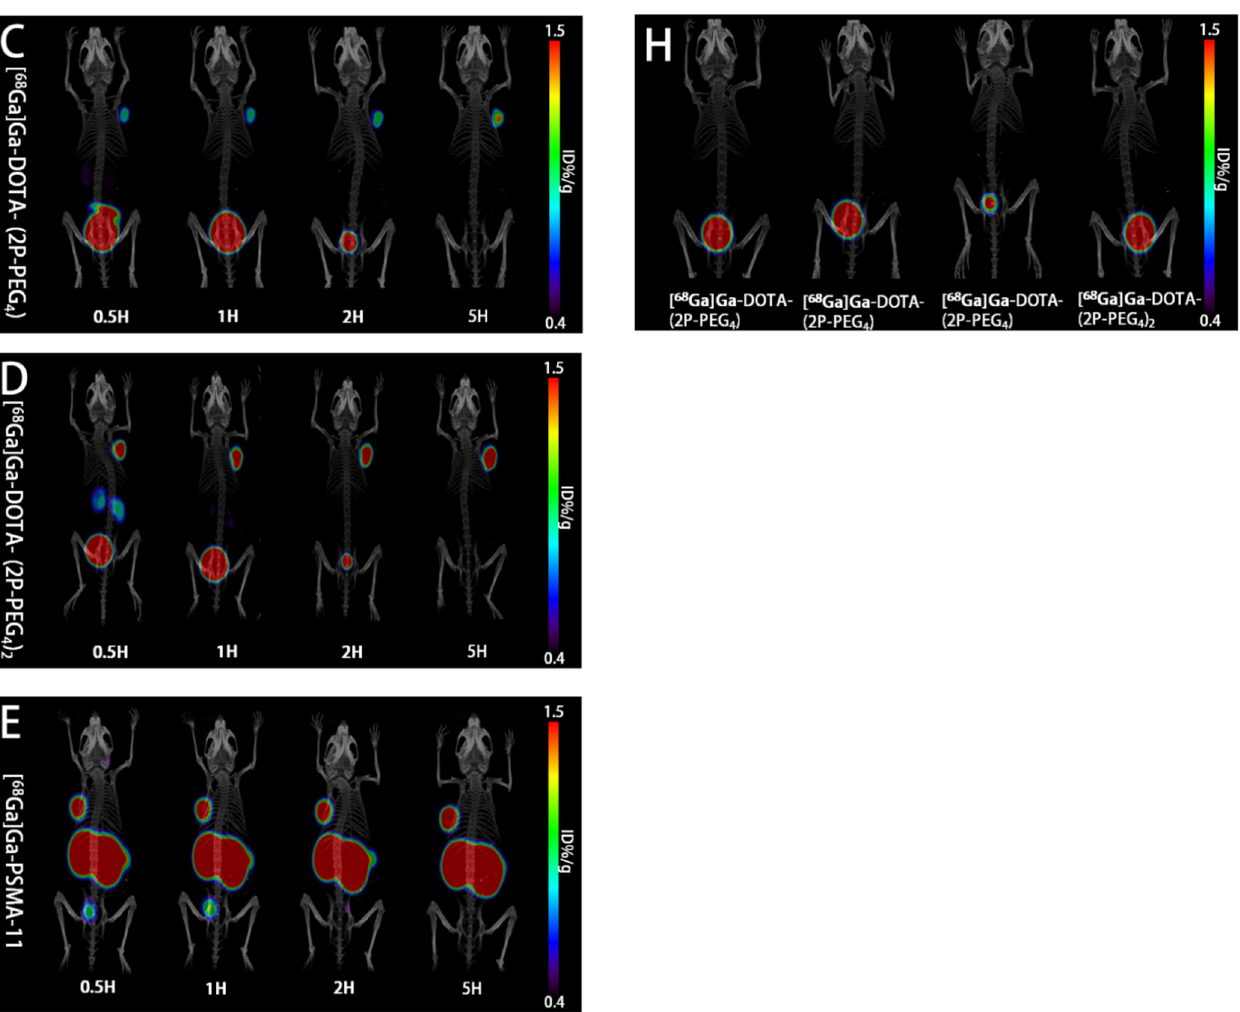
Figure 6. Micro Animal PET/CT and SPECT/CT MIP blending images of PC-3 PIP tumor-bearing mice. ( A – D ): MIP blending images of tumor-bearing mice injected with 68 Ga-labeled (80µCi) DOTA-(1P-PEG 4 ), DOTA-(2P-PEG 0 ), DOTA-(2P-PEG 4 ), and DOTA-(2P-PEG 4 ) 2 at 0.5/1/2/5 h, respectively. ( E ): MIP blending images of tumor-bearing mice injected with [ 68 Ga]Ga-PSMA-11.The kidney uptake of DOTA-(2P-PEG 4 ) 2 was significantly reduced, compared with that of PSMA-11. ( F , G ): The MIP blending images of tumor-bearing mice injected with 177 Lu-labeled DOTA-(2P-PEG 4 ) 2 and PSMA-617 at 6/24/48 h; no obvious radiation signal of DOTA-(2P-PEG 4 ) 2 was detected in the kidney at 6 h. ( H ): The 1 h MIP blending images of tumor-bearing mice that were treated with 50 µg of 2-PMPA previously through caudal vein injection, followed by i.v. injection of (100 uCi) 68 Ga-labeled DOTA-(1P-PEG 4 ), DOTA-(2P-PEG 0 ), DOTA-(2P-PEG 4 ), and DOTA-(2P-PEG 4 ) 2 .